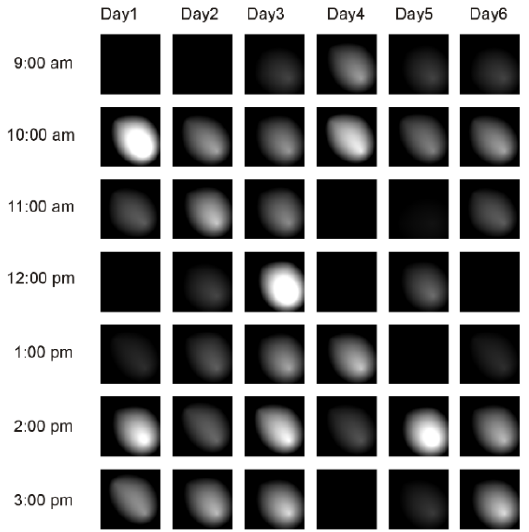
Figure 6. A fragment of an activity map for 6 days.